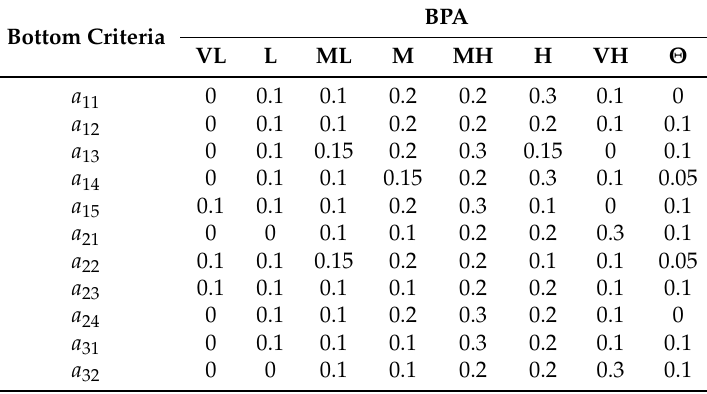
Table 2. The basic probability assignments (BPAs) of bottom criteria [25]: very low (VL), low (L), middle low (ML), middle (M), middle high (MH), high (H), very high (VH). BPA Bottom Criteria VL L